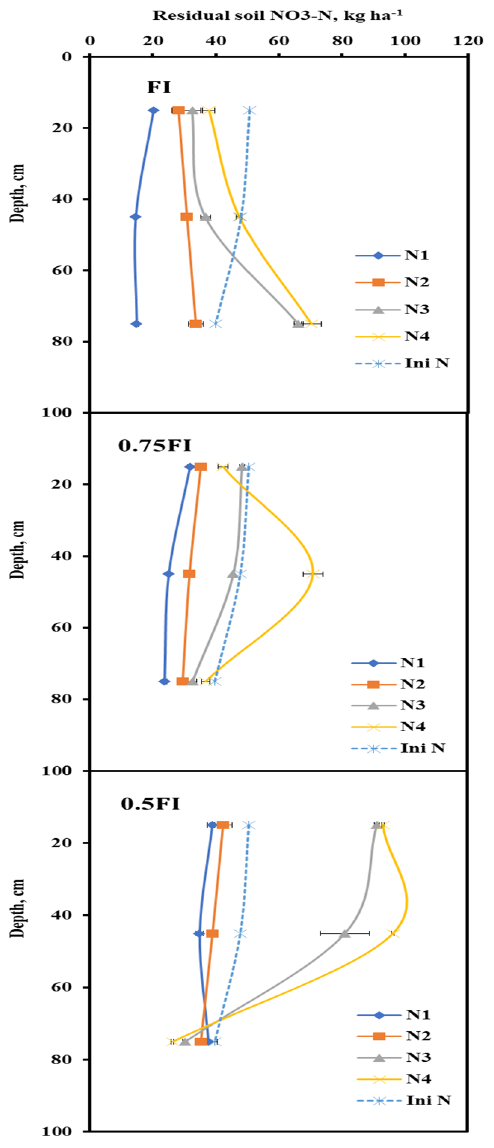
Figure 3. Mean residual soil NO 3 -N at different soil depths after harvest over two years.